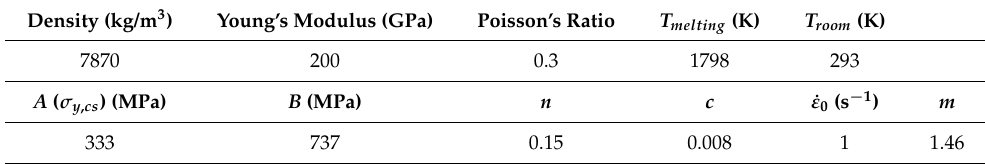
Table 4. Material properties of Johnson–Cook parameters for the carbon steel material of Grade AISI 1020. Density (kg/m 3 ) Young’s Modulus